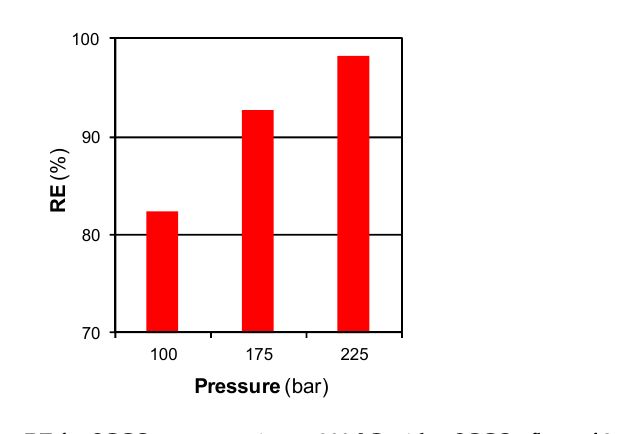
Figure 7. Effect of the SCCO 2 flow on RE for SCCO 2 regeneration at 100 bar and 200 °C during 15 min.